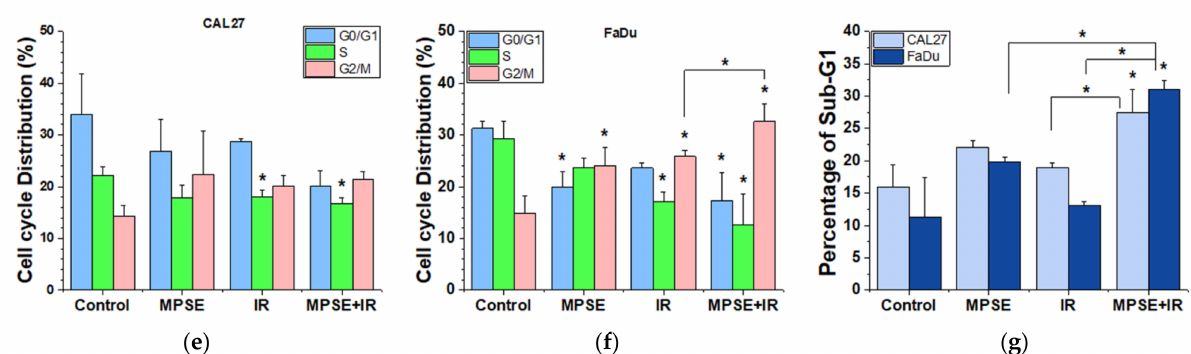
Figure 4. MPSE or PGG enhanced radiosensitivity and induced G2/M phase cell cycle arrest in radioresistant HPV- negative HNSCC. ( a ) Representative image of colony formation assay. ( b , c ) Quantitative analysis of colony formation. Radiosensitization of CAL27 and FaDu cells was analyzed in colony-forming assay after treatment with MPSE and PGG for 24 h followed by irradiation with doses of 0, 2, 4, or 8 Gy. Values are expressed as mean ± SD from three experiments. ( d ) Cell cycle distribution based on DNA content was analyzed by flow cytometry combined with propidium iodide following 24 h of indicated treatment. ( e , f ) The percentage of the cell population in different phases of the cell cycle was determined and plotted as a bar graph. ( g ) The percentage of a cell population in the sub-G1 phase was determined and plotted as a bar graph. All plot data show the mean ± SD ( n = 3). Statistical significance was evaluated by one-way ANOVA, followed by post hoc Tukey’s multiple comparison test (* p < 0.05). MPSE, Maprang seed extract. PGG, pentagalloyl glucose. HNSCC, head and neck squamous cell